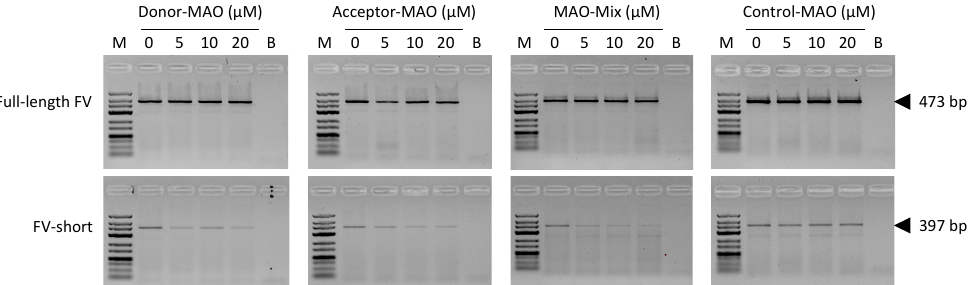
Figure 4. Qualitative analysis of the full-length FV and FV-short transcripts in untreated and treated HepG2 cells. HepG2 cells were treated for 48 h with increasing concentrations (0–20 µ M) of a morpholino antisense oligonucleotide (MAO) targeting the FV-short-specific donor splice site (Donor-MAO), a MAO targeting the FV-short-specific acceptor splice site (Acceptor-MAO), a 1:1 mix of Donor-MAO and Acceptor-MAO, (MAO-mix), or a control MAO with an irrelevant sequence. Total RNA was isolated and reverse transcribed into cDNA. Amplicons corresponding to the full-length FV (top) and FV-short transcripts (bottom) were amplified in separate PCR reactions and PCR products were analysed by gel electrophoresis. M: molecular weight marker, B: blank. Sequencing chromatograms of the full-length FV and FV-short amplicons are shown in Supplementary Figure S1.